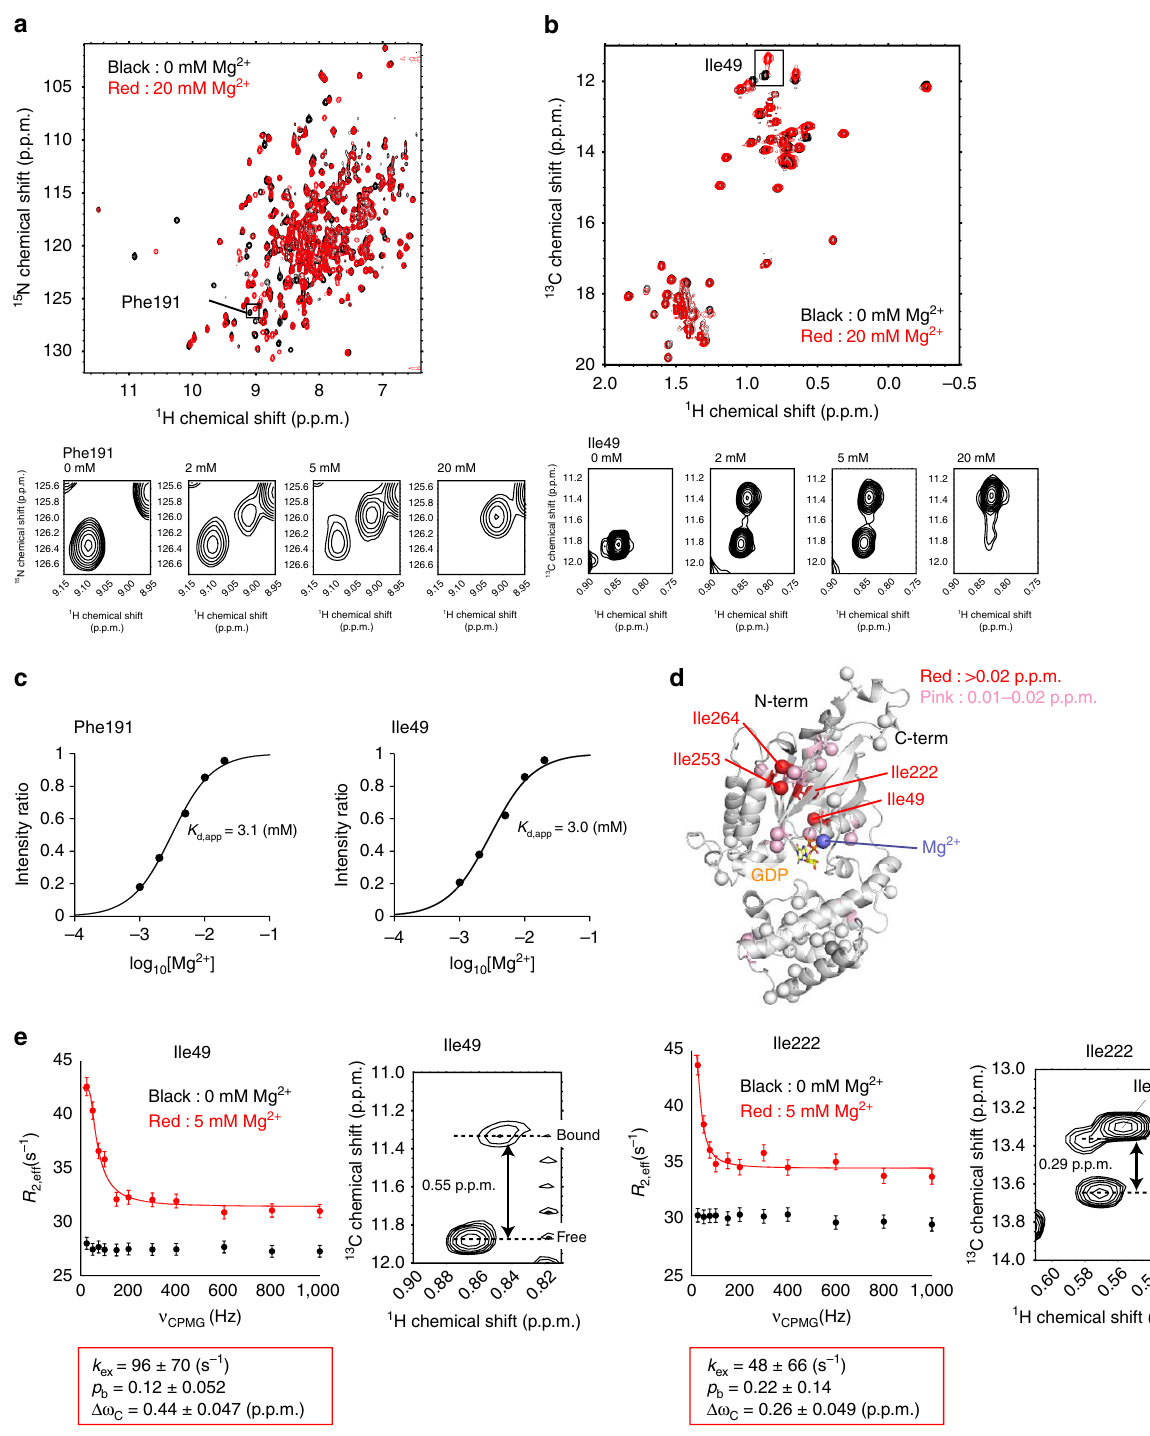
Figure 3 | Effects of Mg 2 þ binding on G a -GDP. ( a ) Overlay of the 1 H- 15 N TROSY spectra of {u- 2 H, 15 N, Ala b , Ile d 1-[ 13 CH 3 ]} G a -GDP in the presence (red) and absence (black) of 20mM Mg 2 þ . The Mg 2 þ concentration-dependence of the Phe191 signal is shown below. ( b ) Overlay of the 1 H- 13 C HMQC spectra of {u- 2 H, 15 N, Ala b , Ile d 1-[ 13 CH 3 ]} G a -GDP in the presence (red) and absence (black) of 20mM Mg 2 þ . The Mg 2 þ concentration-dependence of the Ile49 signal is shown below. ( c ) The intensity ratios of the two signals observed for Phe191 and Ile49 were plotted against the Mg 2 þ concentration. The apparent dissociation constants calculated from the Phe191 and Ile49 signals were 3.1 and 3.0mM, respectively. ( d ) The Ala and Ile methyl groups with significant chemical shift differences are mapped on the crystal structure of G a -GDP bound to Mg 2 þ (PDB ID: 1BOF) 34 . The methyl groups with chemical shift differences larger than 0.02p.p.m. are coloured red, and those within the 0.01 (cid:2) 0.02p.p.m. range are coloured pink. ( e ) 13 C SQ CPMG dispersion experiments of Ile49 and Ile222. The results in the presence of 5mM Mg 2 þ are coloured red, and those in the absence of Mg 2 þ are coloured black. The error bars represent the experimental errors calculated using the equation (16). The fitted parameters are summarized below. The measurements were performed at 20 (cid:2) C with a Bruker Avance 600 spectrometer. The 1 H- 13 C HMQC spectra of the corresponding residues are also